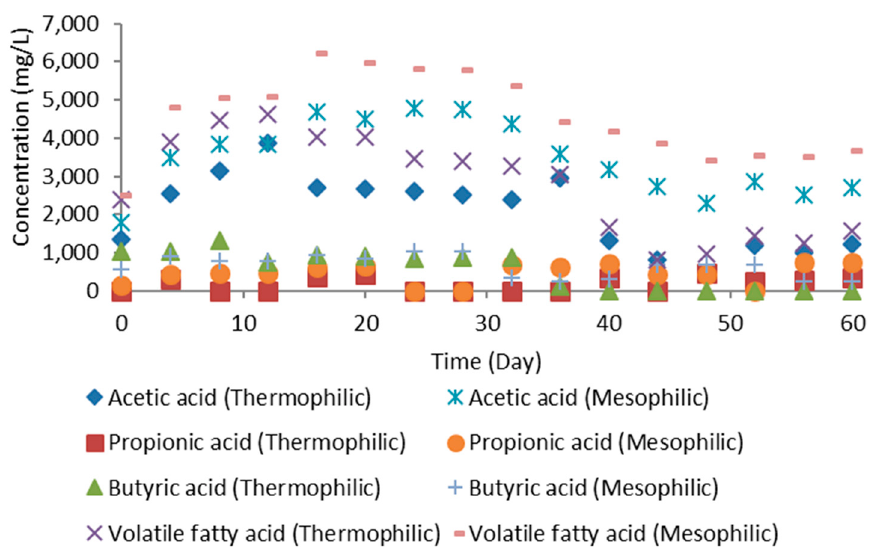
Figure 5. The range of volatile fatty acid of thermophilic and mesophilic effluents during the acclimatization period.